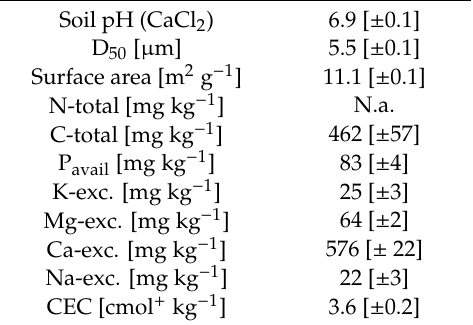
Table 2. Properties of glacial rock flour from Tasersuaq. CEC: cation exchange